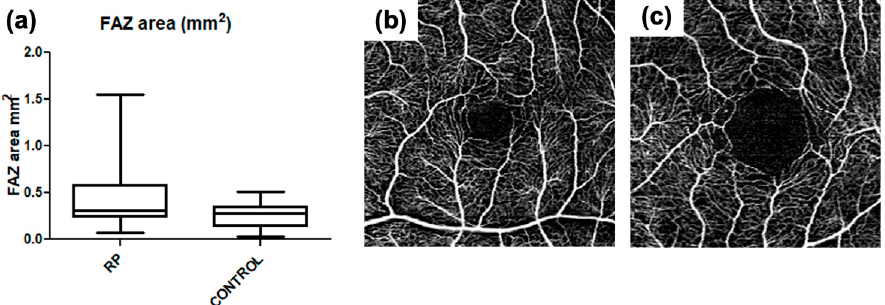
Figure 3. ( a ): Box plot showing the relationship between controls and retinitis pigmentosa patients, of the foveal avascular zone area. ( b , c ): Foveal avascular zone differences between two retinitis pigmentosa patients of different ages. The figures show the 3 mm × 3 mm OCTA of the superficial capillary plexus of two retinitis pigmentosa patients of 12-year-old ( b ) and 59-year-old ( c ), respectively. The foveal avascular zone enlargement is evident in the older patient.